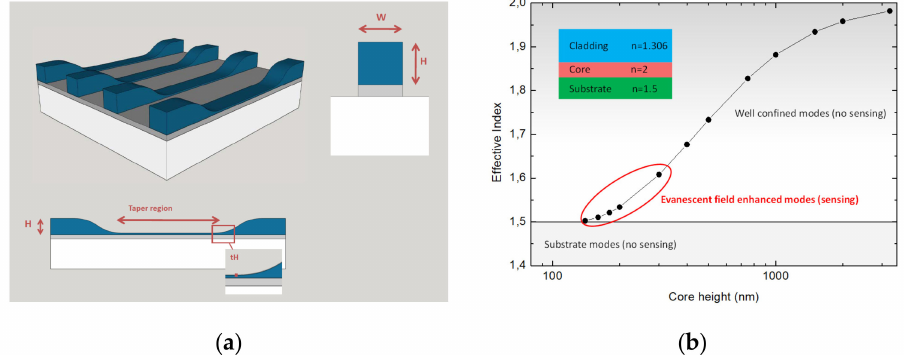
Figure 1. ( a ) Tapered waveguide design scheme, being W the width of the waveguide, H the height of the un-tapered region. The zoom region shows the tH the thickness of the taper region. ( b ) Calculation of the waveguide mode dispersion as a function of the height of the ridge waveguide, the inset shows the refractive indexes used for each layer for the